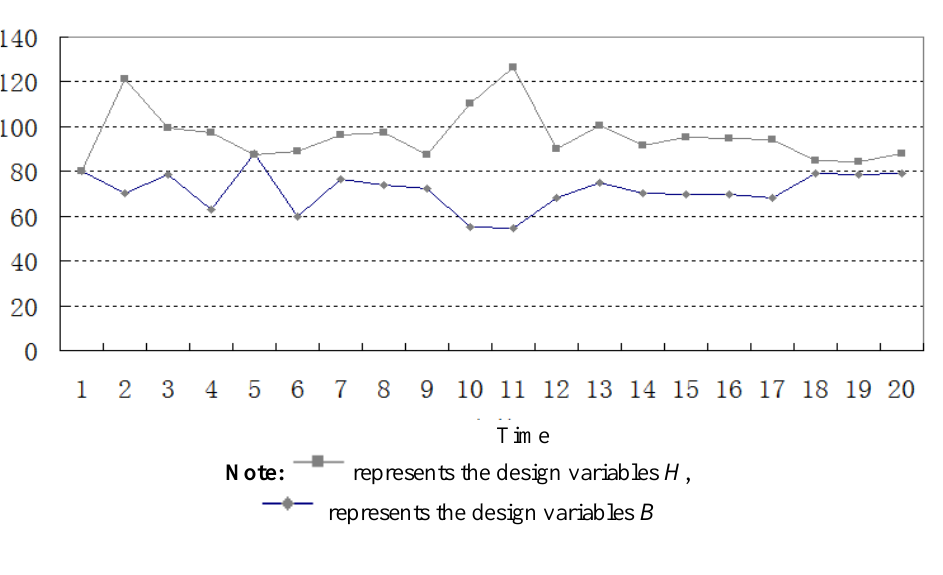
Figure 5. Curve design